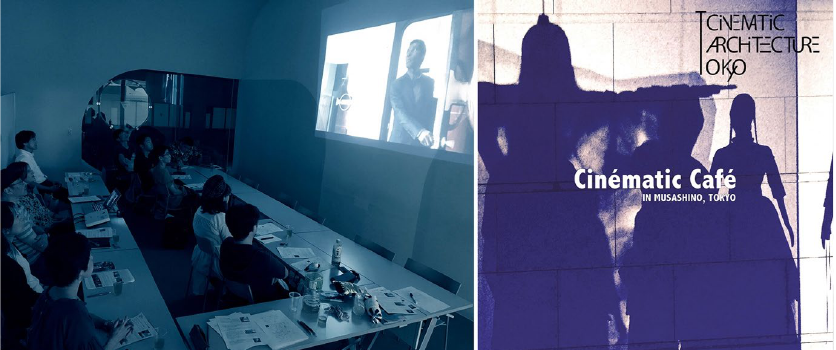
Figure 26 Discussing Jim Jarmusch’s the Limits of Control in the Cinématic Cafe in Musashino. / The poster for the “Shadow”